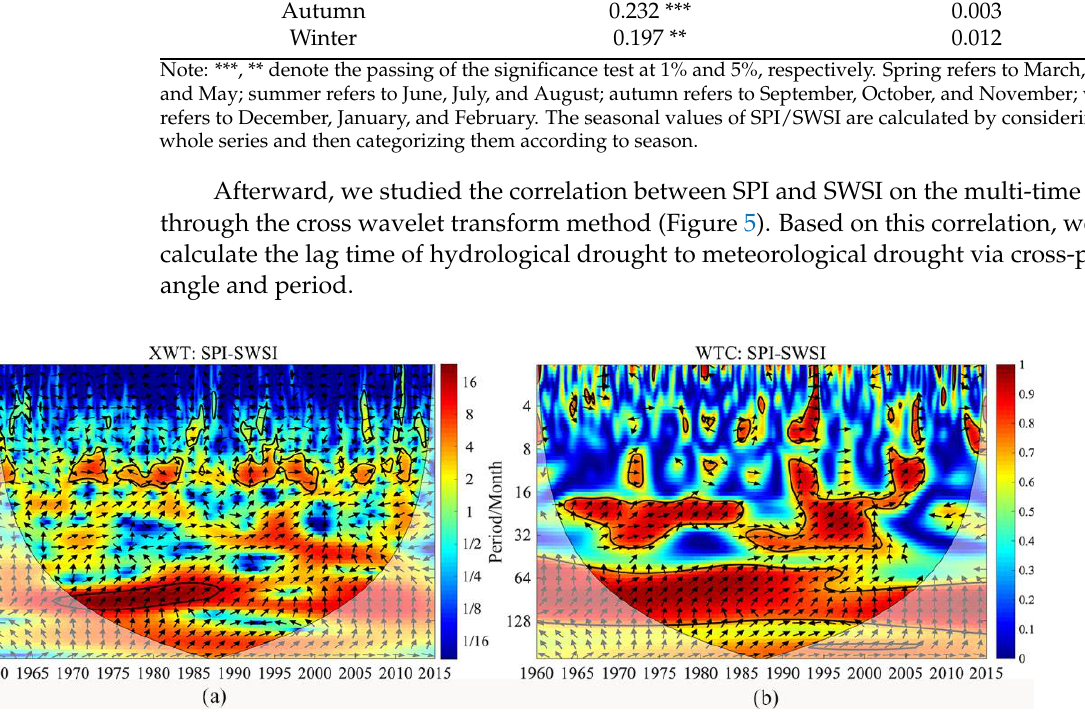
Figure 5. The cross wavelet transform XWT ( a ) and the wavelet coherence WTC ( b ) between SPI and SWSI. Figure 5a is the cross wavelet transform XWT, and Figure 5b is the wavelet coherence WTC between SPI and SWSI. The shades of colors indicate the level of energy density, where red indicates high energy density and blue indicates low energy density. The closed thick black solid line indicates that the 5% significance test is passed. The thin black solid line of the cone is the cone of wavelet influence (COI), which signifies the area where the edge effect of the wavelet transform data has a greater influence. The direction of the arrows specifies the relative phase difference between meteorological and hydrological droughts, where the horizontal arrow to the right highlights the same phase between the meteorological and hydrological droughts, and the horizontal arrow to the left indicates the opposite phase between the two. The vertical upward arrow asserts that the meteorological drought occurred one quarter cycle earlier than the hydrological drought, and the vertical downward arrow confirms that the hydrological drought commenced one quarter cycle earlier than the meteorological drought.